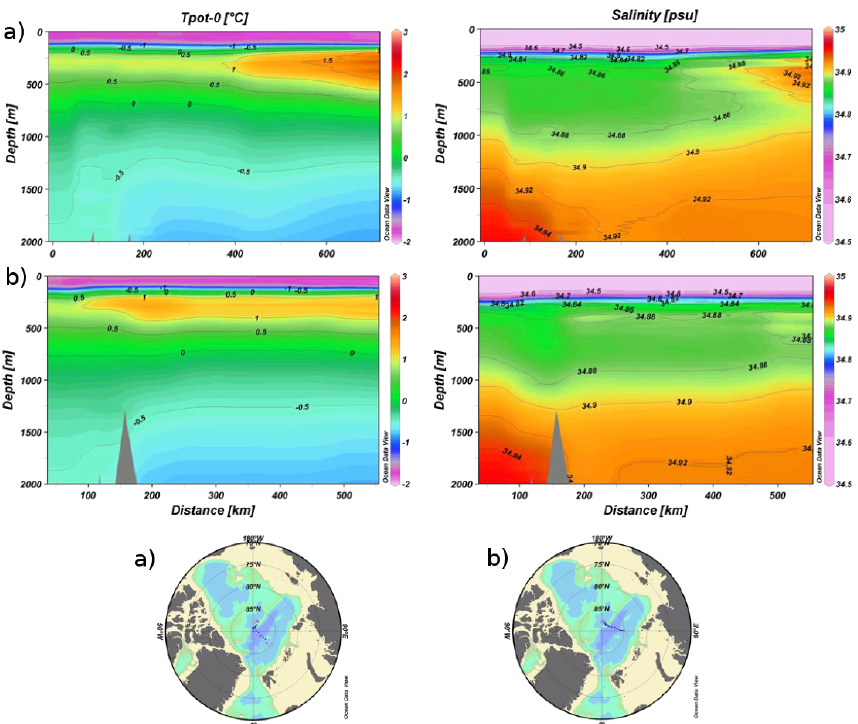
Fig. 16b. Sections of potential temperature and salinity from the Gakkel Ridge (right) across the Amundsen Basin and the Lomonosov Ridge into the Makarov Basin from different years: upper panel and left map – 2005 ( Oden ); lower panel and right map – 2007 ( Polarstern